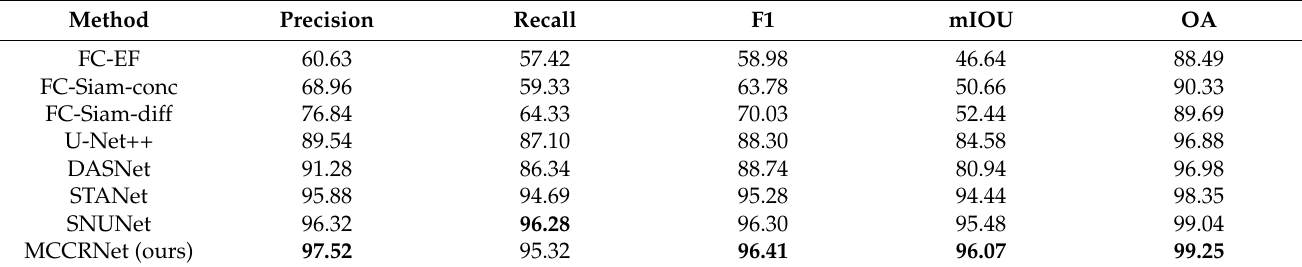
Table 7. Comparison of results on the CCD dataset. The bold numbers indicate the best results.